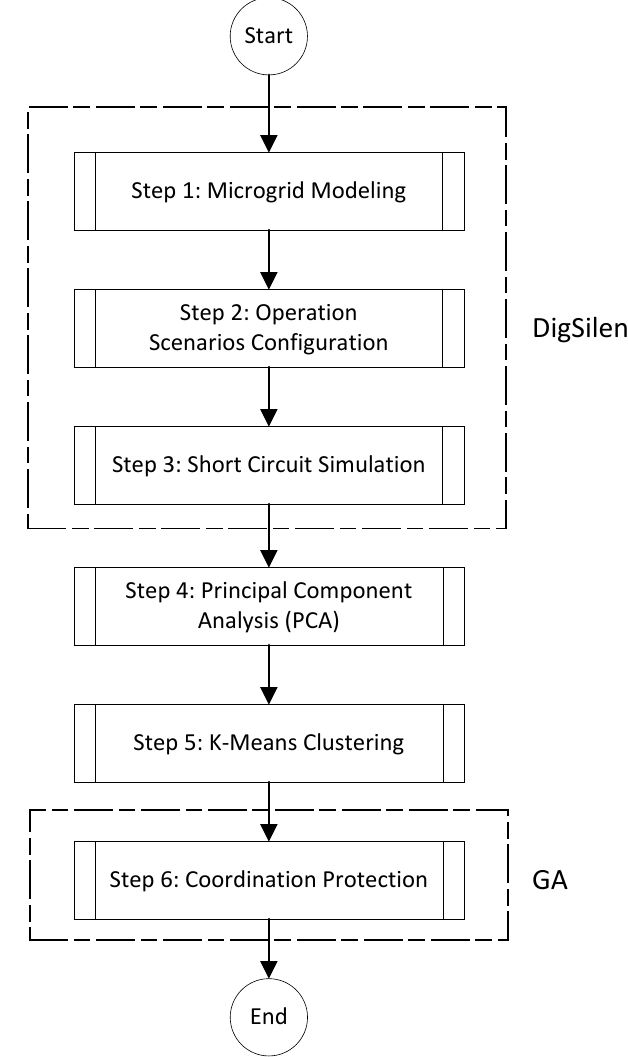
Figure 2. Methodology flowchart